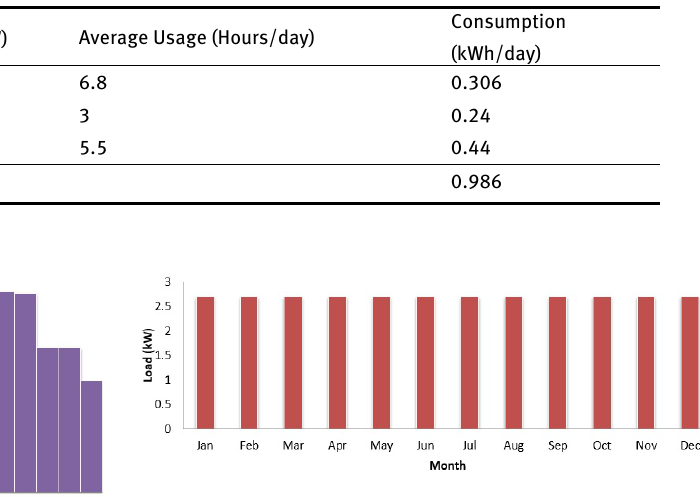
Figure 4: Monthly Deferrable